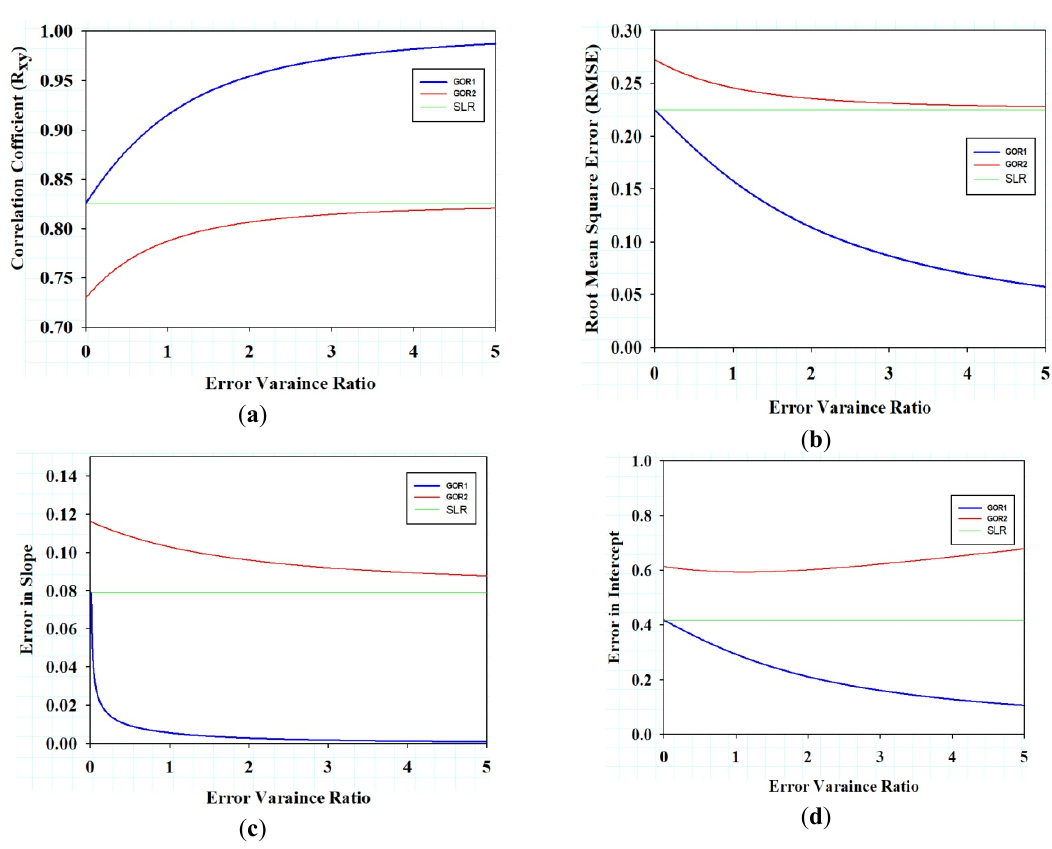
Figure 10. Comparison of the uncertainty in regression parameters for (m b,NEIC − M wg ) data pairs using GOR1, GOR2, and SLR approaches considering function of error variance ratio: ( a ) Correlation Coefficient determination (R xy ), ( b ) Root mean square error (RMSE), ( c ) uncertainty values of slope and ( d ) uncertainty of intercept.